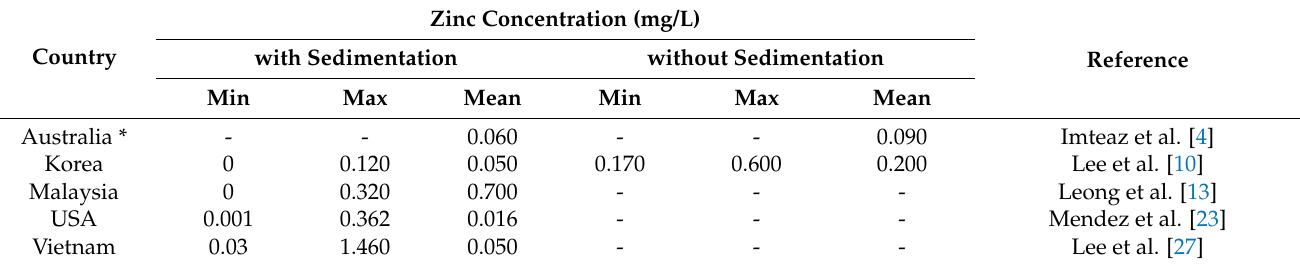
Table 6. Measurements on zinc concentration. Country